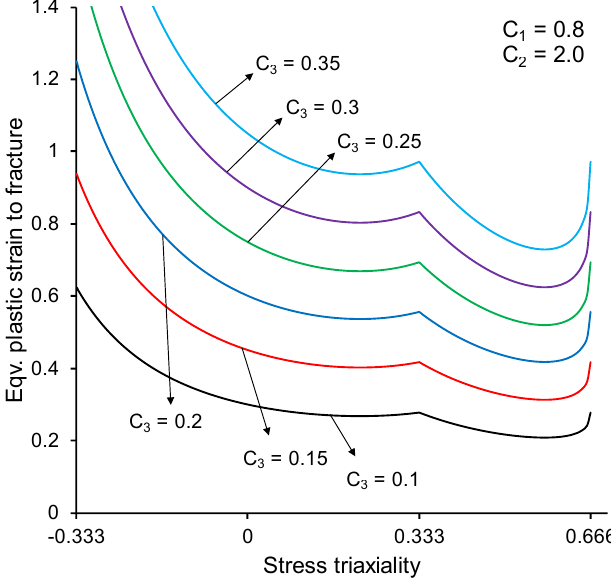
Figure 6. Effect of C 3 on the proposed fracture model for C 1 = 0.8, C 2 =